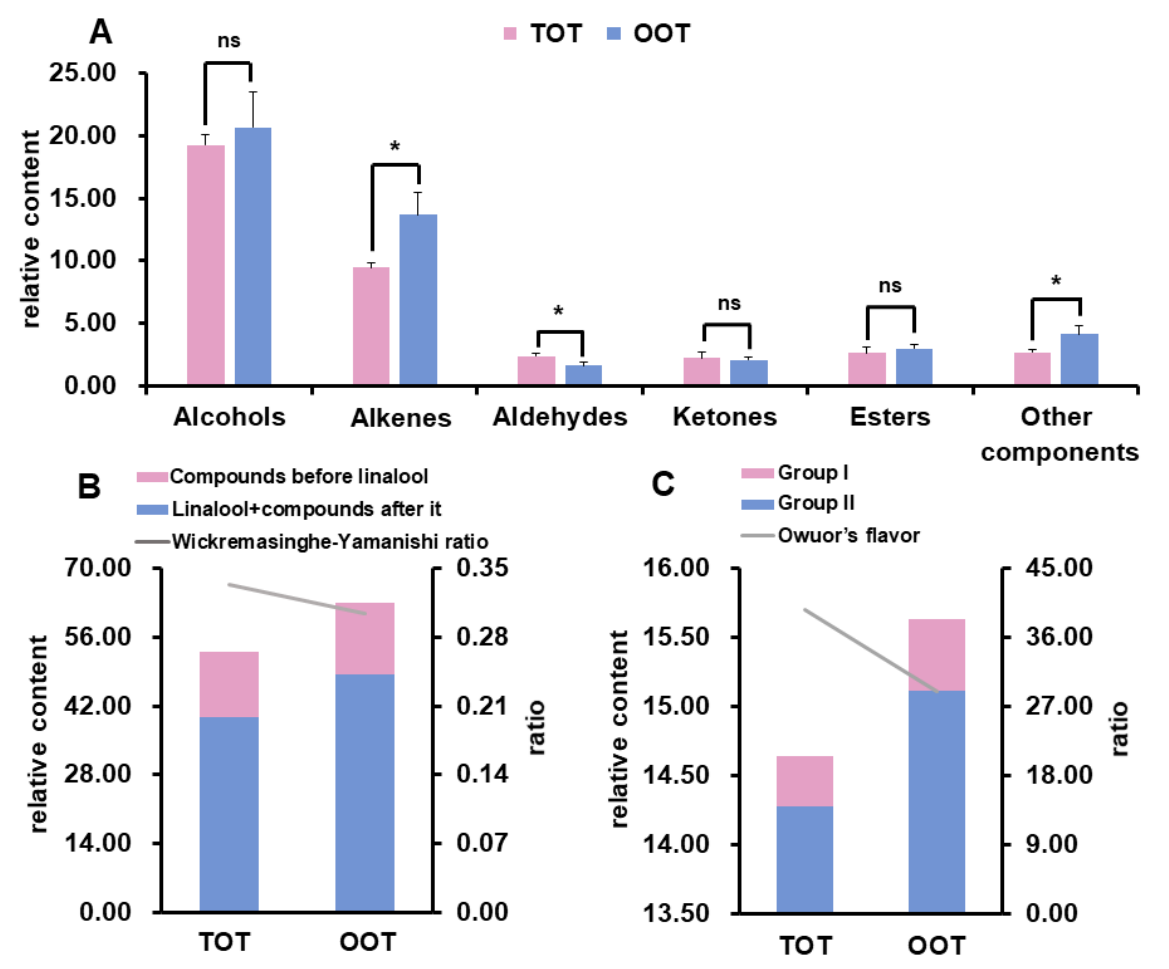
Figure 2. Characteristics of the volatile components of TOT and OOT. ( A ) The differences in six volatile categories between TOT and OOT. ( B ) The Wickremasinghe-Yamanishi ratio of TOT and OOT. t -test was used to identify significant differences (ns = not significant; * p < 0.05). ( C ) The Owuor’s flavor index of TOT and OOT. TOT: Tibet oolong tea; OOT: Origin oolong tea.